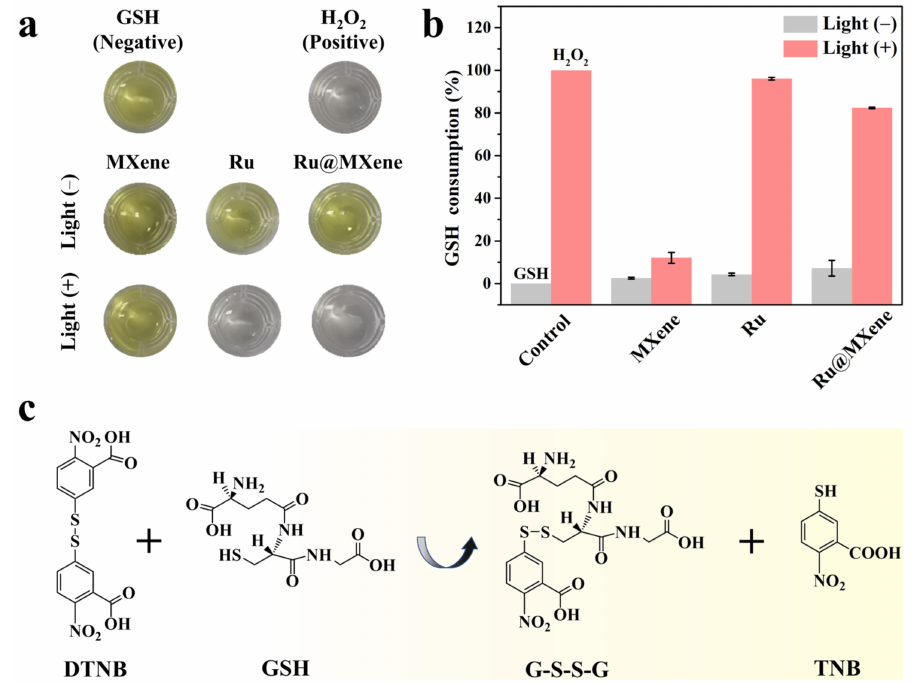
Figure 11. Antibacterial mechanism evaluations involving GSH consumption: ( a ) Photographs of the color change in GSH solution after incubating with various materials with or without xenon lamp illumination (150 mW/cm 2 , 30 min). ( b ) Corresponding GSH consumption rate (n = 3). ( c ) Chemical reaction between DTNB and GSH.